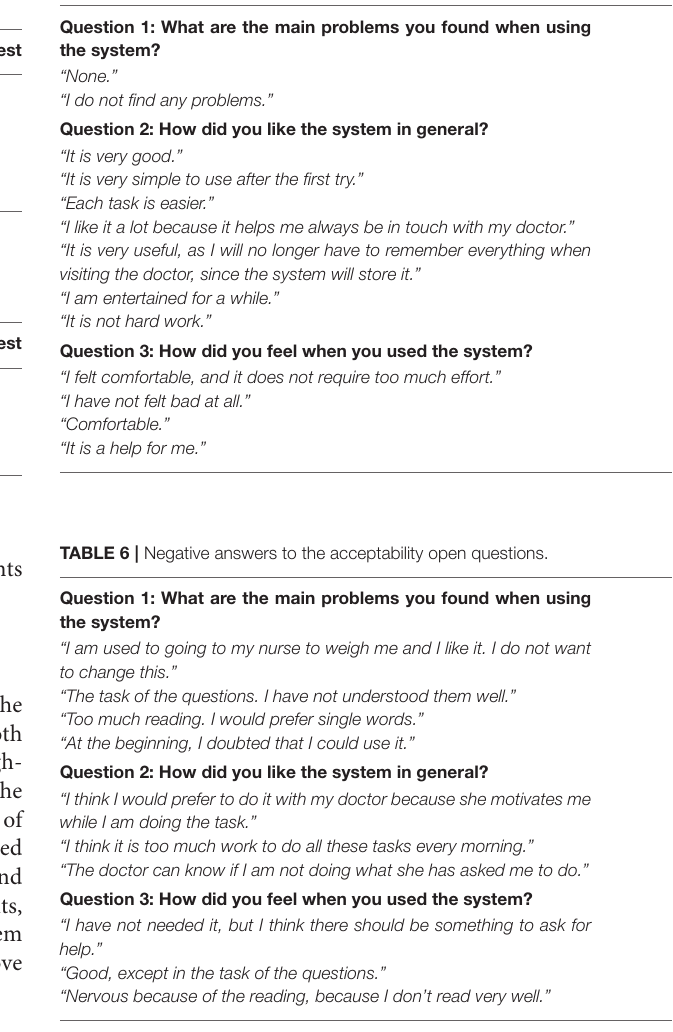
TABLE 5 | Positive answers to the acceptability open questions.